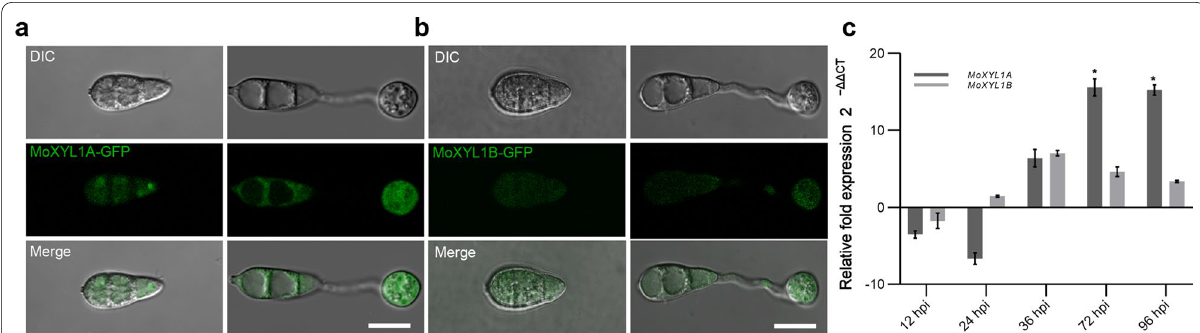
Fig. 4 Subcellular localization of the relative expression xylanases at different stages of M. oryzae - host interaction. a Localization of MoXYL1A in the aberant conidia, conidia germination and appressorium formation stages of M. oryzae was determined by transforming a MoXYL1A-GFP fusion construct into the protoplast of the wild type strain Guy11 and examining fungal cells using the Scale bar 20 µm. DIC indicates bright field = illumination. GFP was excited at 488 nm. b Localization of MoXYL1B was assessed as in ( a ). MoXYL1B-GFP signal is evident in the conidium and appressorium. Scale bar 20 µm. c In-planta expression of MoXYL1A and MoXYL1B transcripts during distinct stages of host–pathogen interaction = was assessed by qRT-PCR. Vegetative hyphae were used as a control stage and the expression level of MoXYL1A and MoXYL1B at the hyphal stage was set to 1. Error bars represent standard deviation (SD). SD was calculated from three independent biological replicates along with three technical replicates. (*, P < 0.05 by t-test)